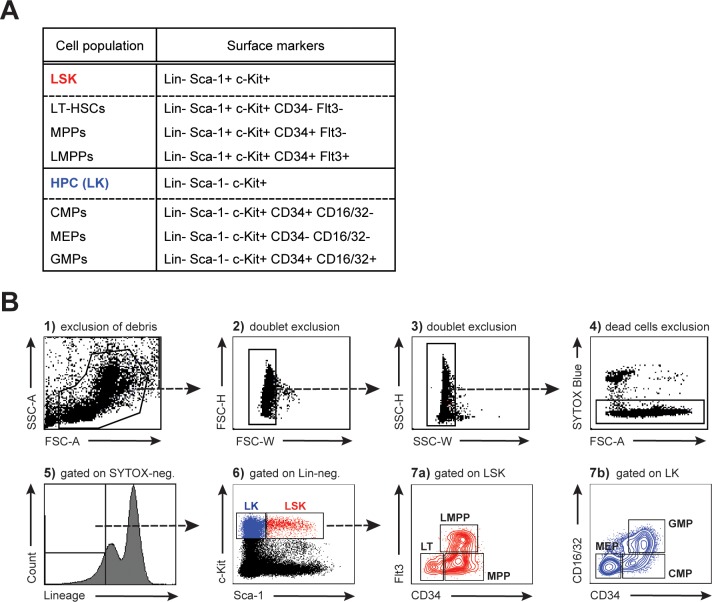
HSPC surface markers and gating strategy.(A) HSPCs are identified by their ‘LSK’ profile according to the absence of mature lineage markers (Lin-) together with expression of Sca-1 and c-Kit (Spangrude et al., 1988). While CD34- Flt3- long-term (LT) repopulating HSCs reside at the top of the hierarchy able to reconstitute all hematopoietic lineages, CD34+ Flt3- multipotential progenitors (MPPs) (or short-term (ST)-HSCs) have reduced reconstitution capacity and contain early myeloid-restricted progenitors (Osawa et al., 1996; Christensen and Weissman, 2001; Arinobu et al., 2007). The first lymphoid-primed multipotential progenitors (LMPPs) arise from the MPP population along with upregulation of Flt3 (Adolfsson et al., 2001; Luc et al., 2008). While LMPPs combine lymphoid and granulocyte-monocyte (GM) differentiation potentials, MPPs further commit to Lin- Sca-1- c-Kit+ (‘LK’) CD34+ common myeloid progenitors (CMPs) that integrate GM and megakaryocyte-erythroid (MkE) potentials (Adolfsson et al., 2005; Arinobu et al., 2007). This dual propensity is ultimately resolved in megakaryocyte-erythroid (MEP) and granulocyte-monocyte (GMP) progenitors based on differential expression of CD34 and CD16/32 (FcγIII/II) (Akashi et al., 2000). (B) Representative FACS gating strategy of BM using the HSPC staining panel described above. (FSC = forward scatter, SSC = side scatter, A = area, W = width, H = height).